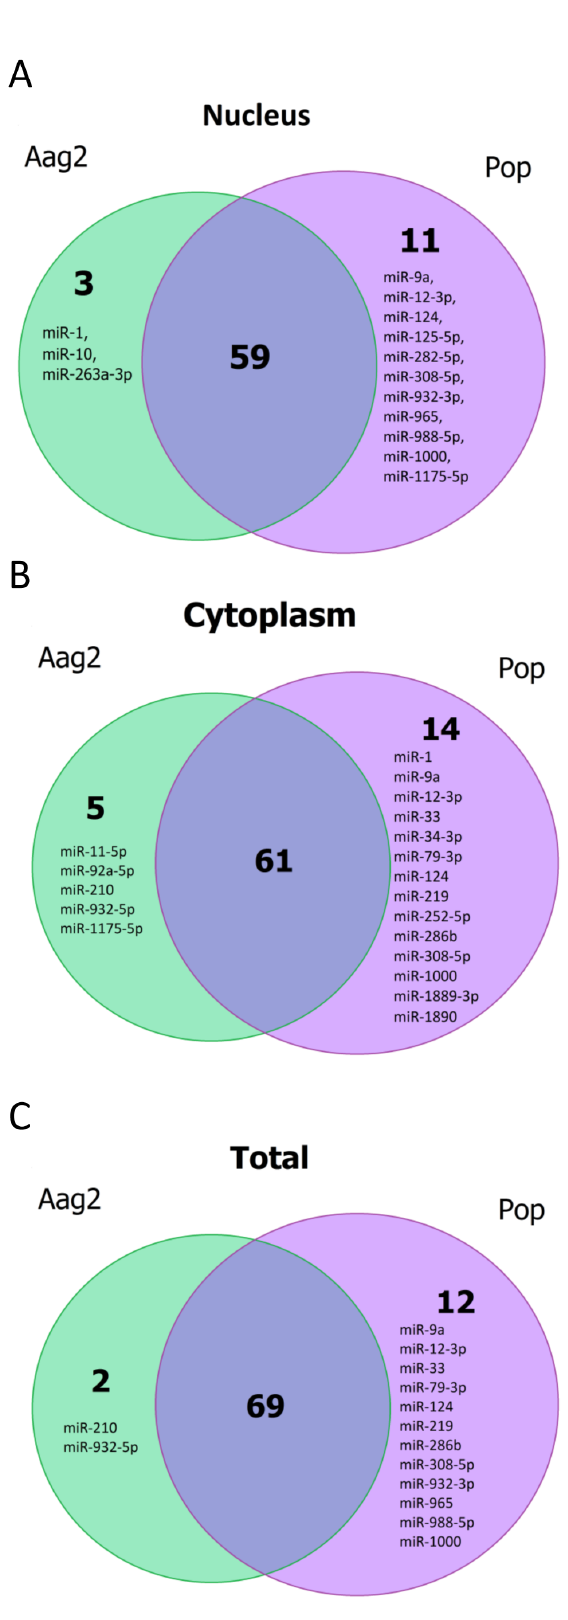
Figure 8. miRNA expression comparison in the nucleus (A), the cytoplasm (B) and the nucleus and the cytoplasm combined (C) between Aag2 and Pop cells.